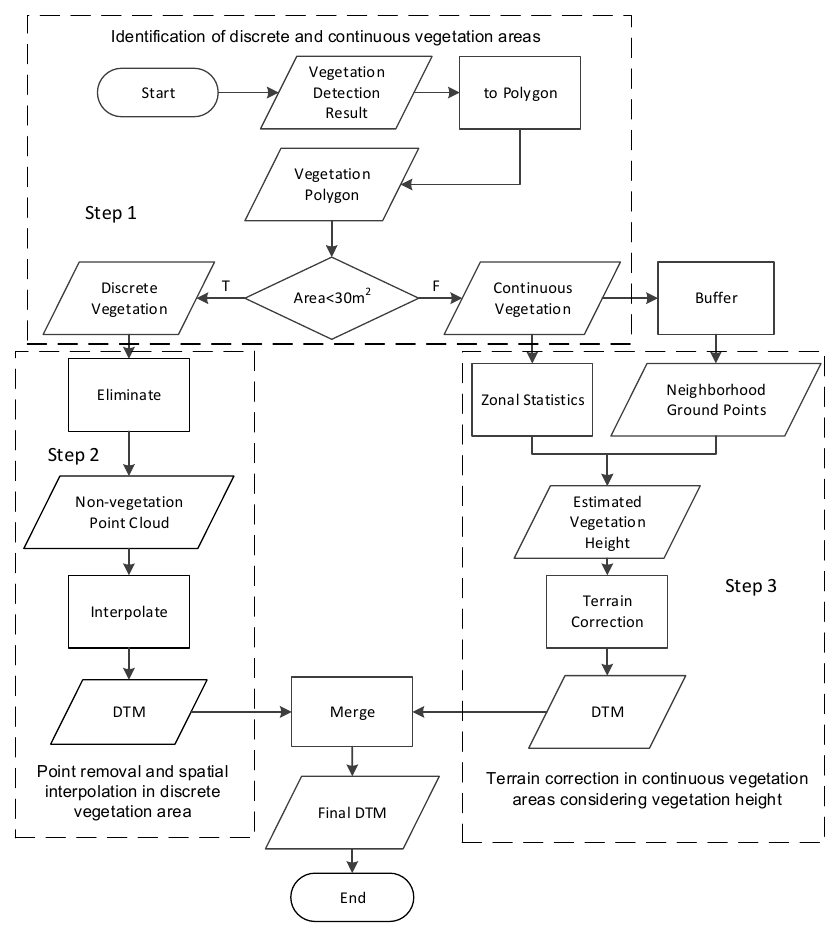
Figure 3. Workflow of terrain correction.